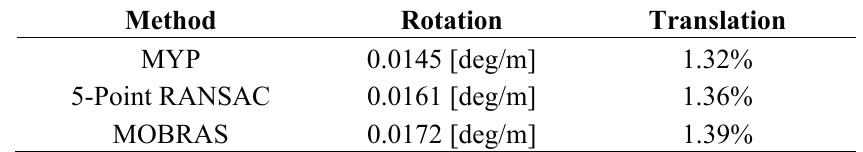
Table 3. Overview of average translation and rotation error on KITTI Sequences